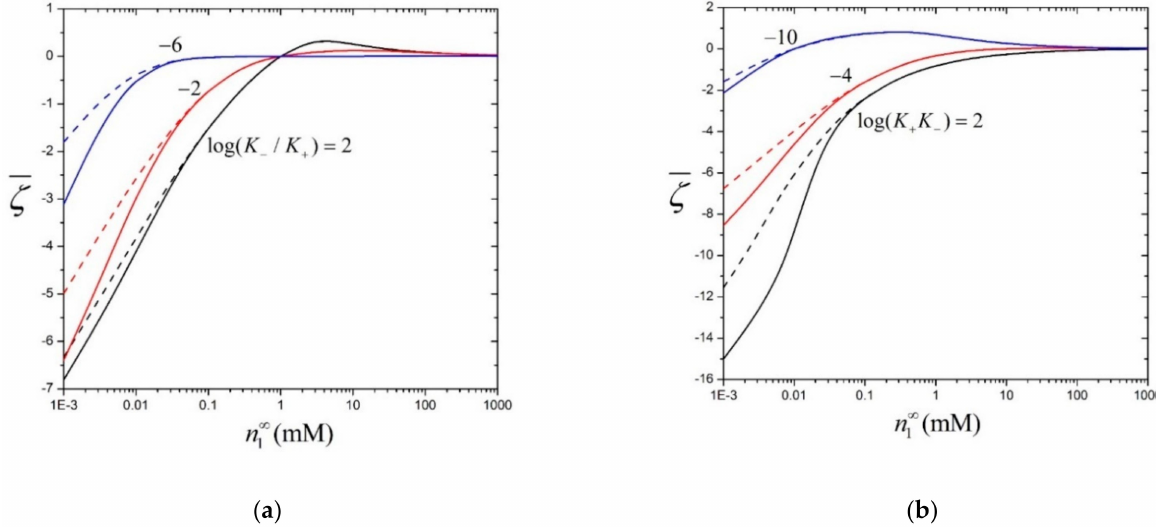
Figure 3. The dimensionless zeta potential ζ versus the bulk concentration n ∞ fibrous medium with a = 100 nm and N = 1 × 10 16 site/m 2 : ( a ) K + K − = 10 − 6 M 2 ; ( b ) K − / K + = 10 − 2 . The solid and dashed curves represent the cases ϕ = 0.3 and ϕ = 0,